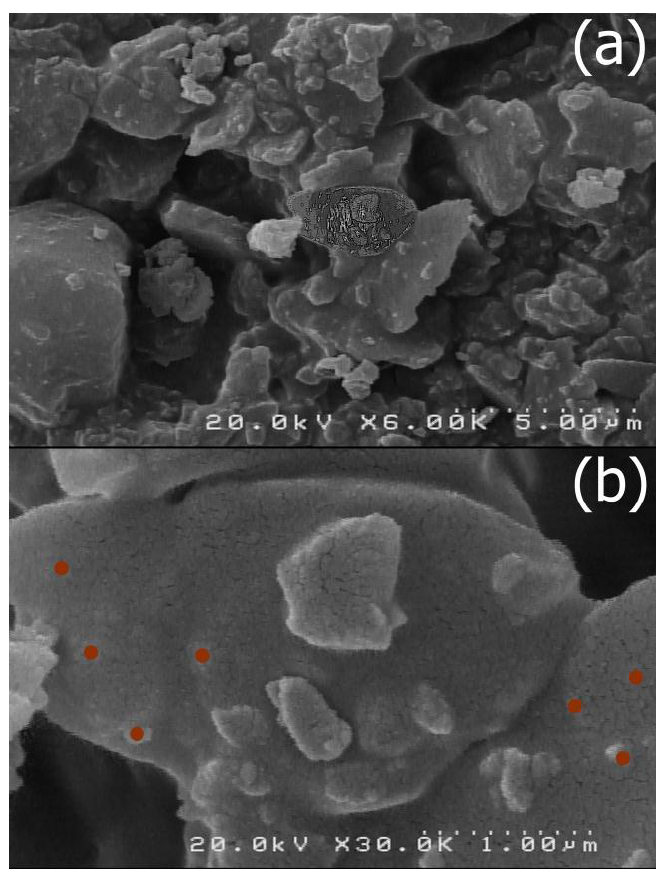
Figure 6. (a) SEM of TC@MIL-100. (b) Red spots indicate some of nanoparticles. Figure 6. ( a ) SEM of TC@MIL-100; ( b ) Red spots indicate some of